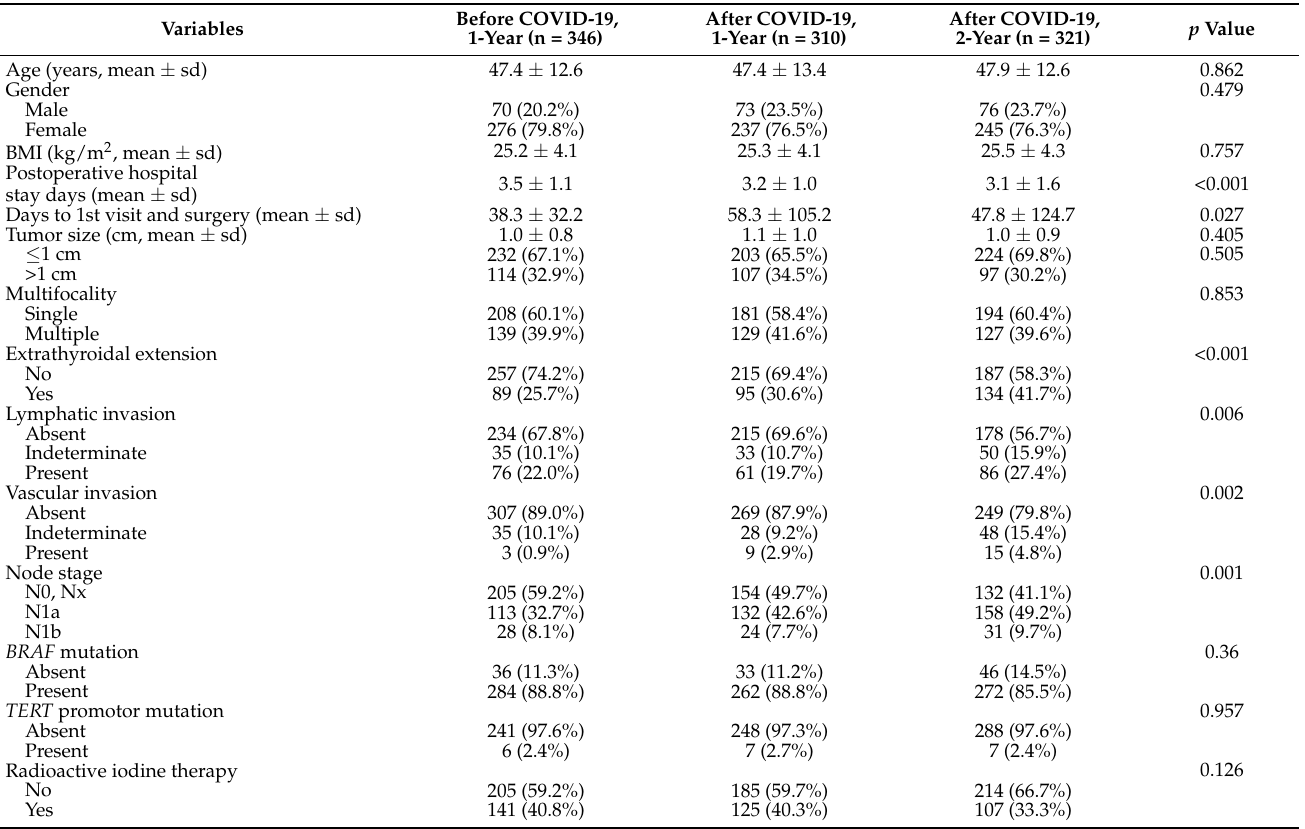
Table 2. Clinical and pathologic characteristics of papillary thyroid cancer